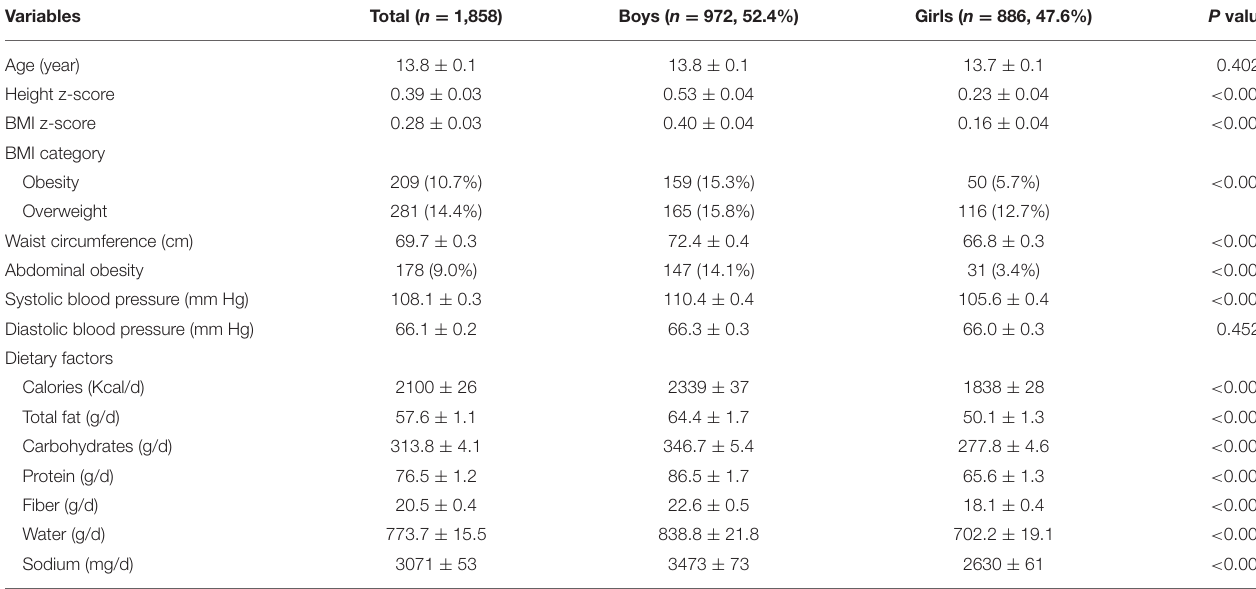
TABLE 1 | Demographic characteristics of study participants.